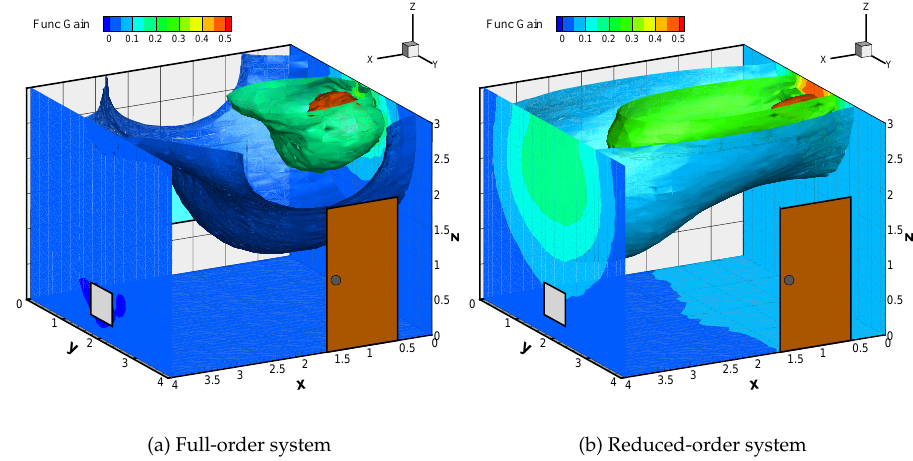
Figure 7. Functional gains for the temperature for different systems.